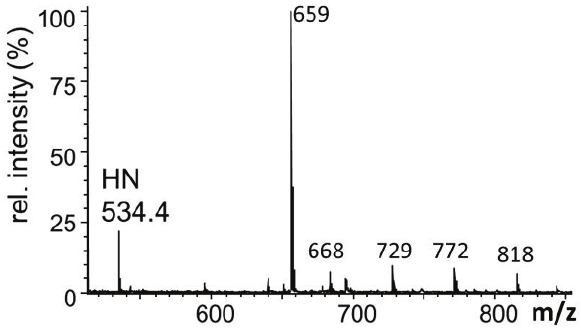
Figure 10. MALDI-MS spectrum of the permethylated O -glycan alditols derived by reductive β -elimination from hDG5 coexpressed with dGlcAT-S in CHO-Lec2 cells. No glucuronylation of O -glycans was observed. Non-labeled signals in the mass range up to m / z 1000 are matrix-derived signals or derived from a polyhexose impurity. Short notation of glycan structures: H, hexose; N, N -acetylhexosamine.